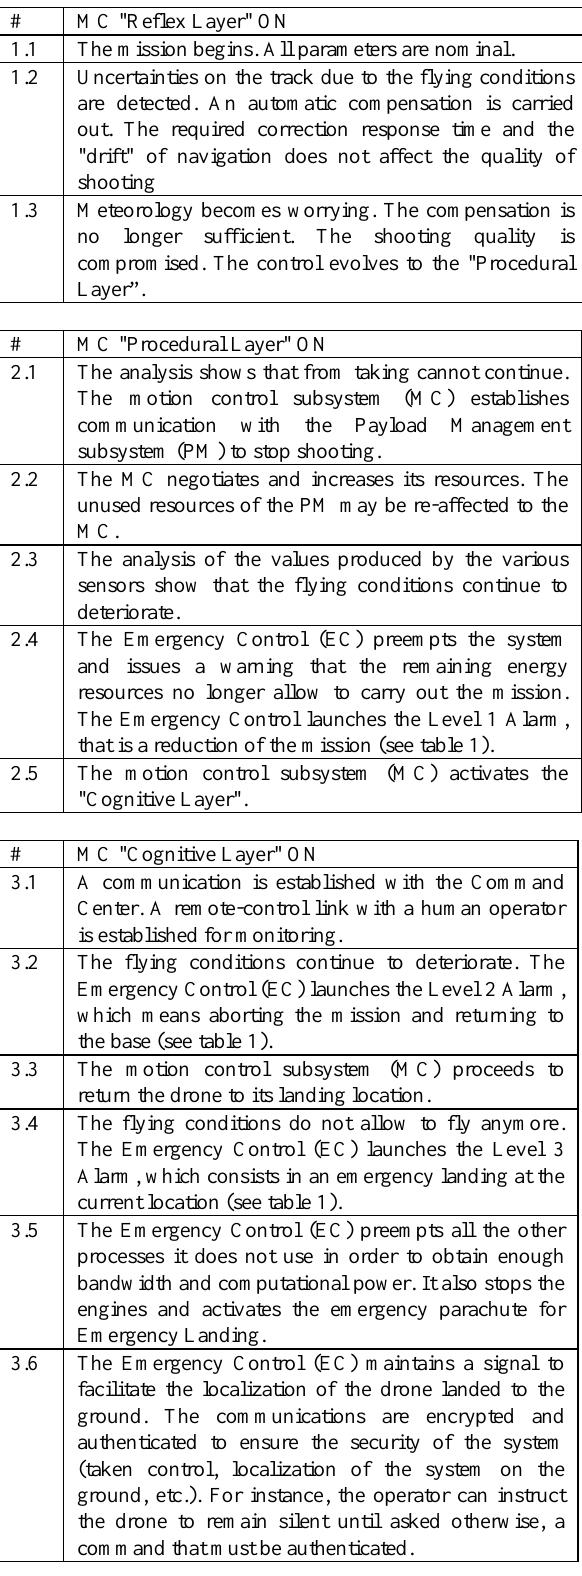
Table 2: Dynamic adaptation of the Motion control (MC)